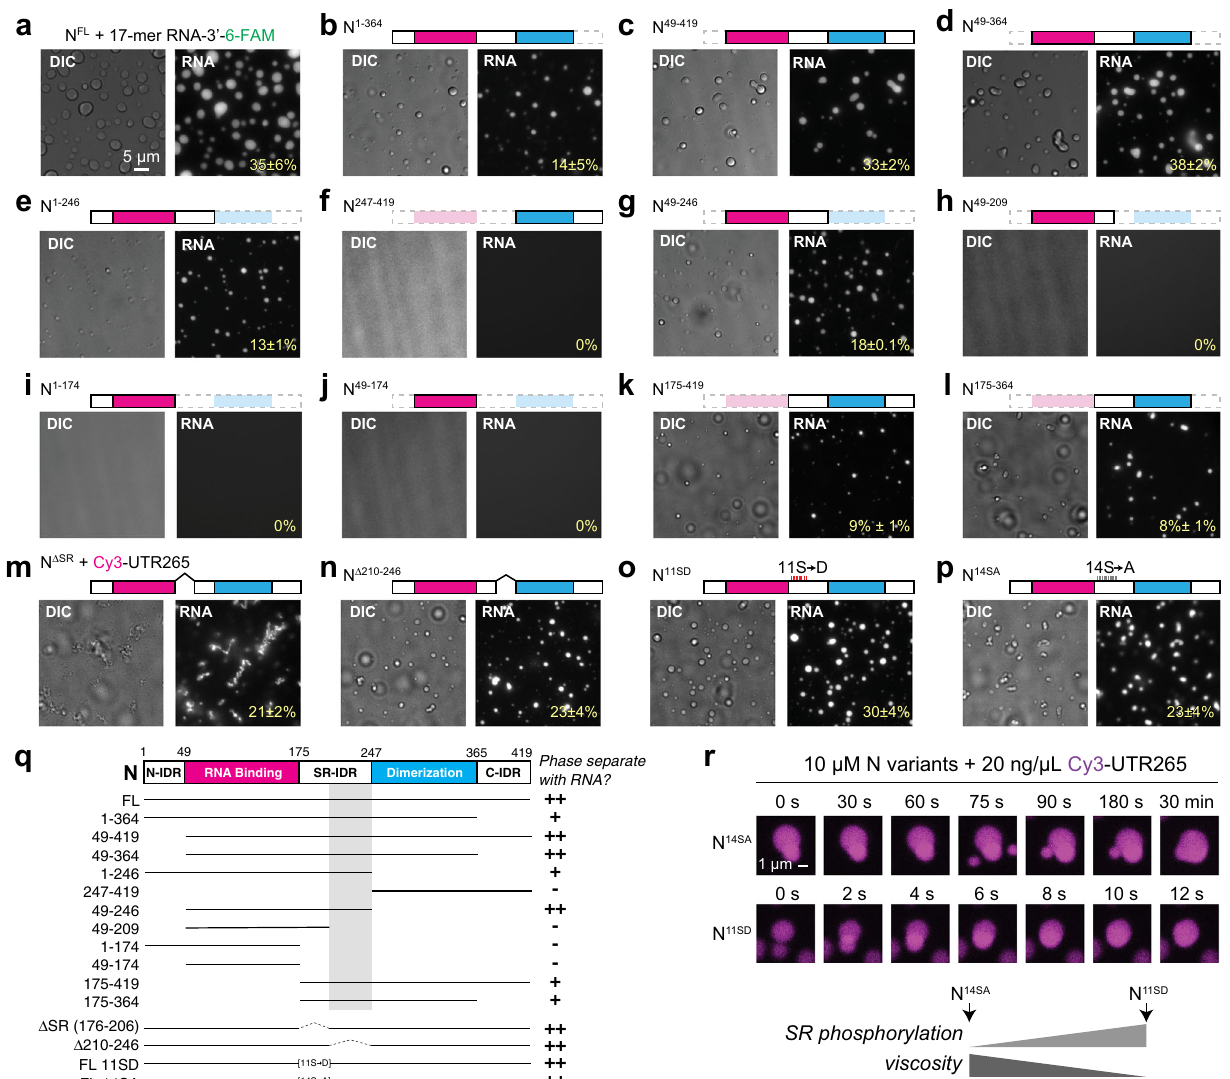
Fig. 3 The central intrinsically disordered region is important for RNA-dependent phase separation of N protein. a – l DIC and fl uorescence images of the mixtures of 2 µ M 17-mer ssRNA and 10 µ M N protein variants: a full-length N 1 – 419 ; b N 1 – 364 ; c N 49 – 419 ; d N 49 – 364 ; e N 1 – 246 ; f N 247 – 419 ; g N 49 – 246 ; h N 49 – 209 ; i N 1 – 174 ; j N 49 – 174 ; k N 175 – 419 ; l N 175 – 364 . m – p DIC and fl uorescence images of mixtures of 20 ng/ µ L Cy3-UTR265 RNA and 10 µ M of N variants: m N Δ SR (note that this construct shows signi fi cant aggregation on its own; see Supplementary Fig. 3e); n N Δ 210 – 246 ; o N 11SD ; p N 14SA . Images were taken 30 min after mixing N protein variants with RNA. Scale bar, 5 µ m ( a – p ). Percentage values indicate the percentage of total RNA fl uorescence within condensates, calculated from two ( f – m ) or three ( a – e , n – p ) fi elds. See Supplementary Fig. 3b for SDS – PAGE analysis of puri fi ed proteins, Supplementary Fig. 3d for phase separation of proteins without RNA, and Supplementary Fig. 3f for phase separation of N 1 – 364 , N 1 – 246 , and N 49 – 246 with UTR265 RNA. q Summary of phase separation behaviors of N protein variants shown in a – p . Domain schematic of the SARS-CoV-2 N protein, with known domains marked. Gray shading indicates the region implicated in N + RNA phase separation. + indicates 1 – 15% of RNA fl uorescence within condensates; ++ indicates 16% or higher. r Fusion events of phospho-resistant (N 14SA ) and phospho-mimetic (N 11SD ) N protein droplets (representative of four fusion events observed). Imaging was performed 30 min after initial mixing. Scale bar, 1 µ